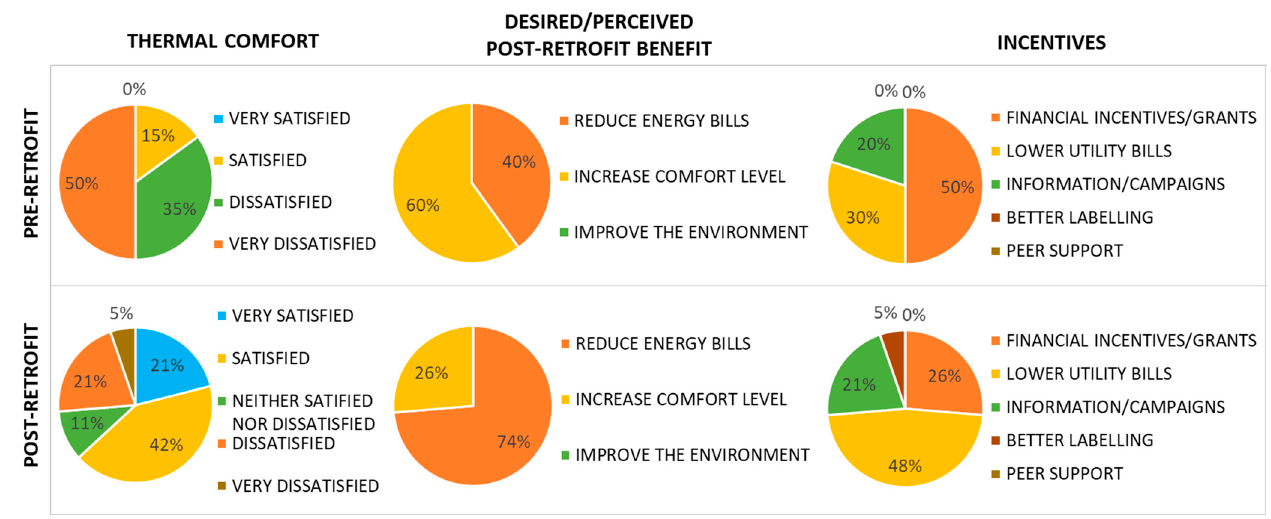
Figure 2. Perceived co-benefits or energy performance before and after the retrofit program. Source: Own elaboration using Stephenson et al. [30] data.